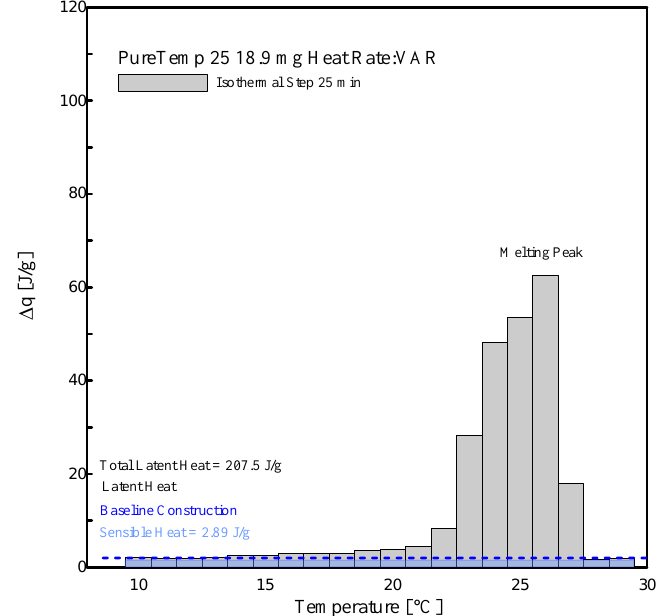
Figure 18. Histogram view of stored heat ∆ q (T) for PureTemp 25, at several temperature intervals and adopting an isothermal time step of 25 min.